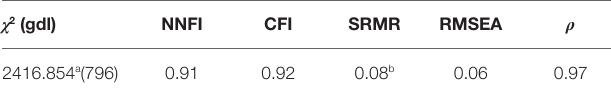
TABLE 10 | Fit indices model modified –creativity outcome.